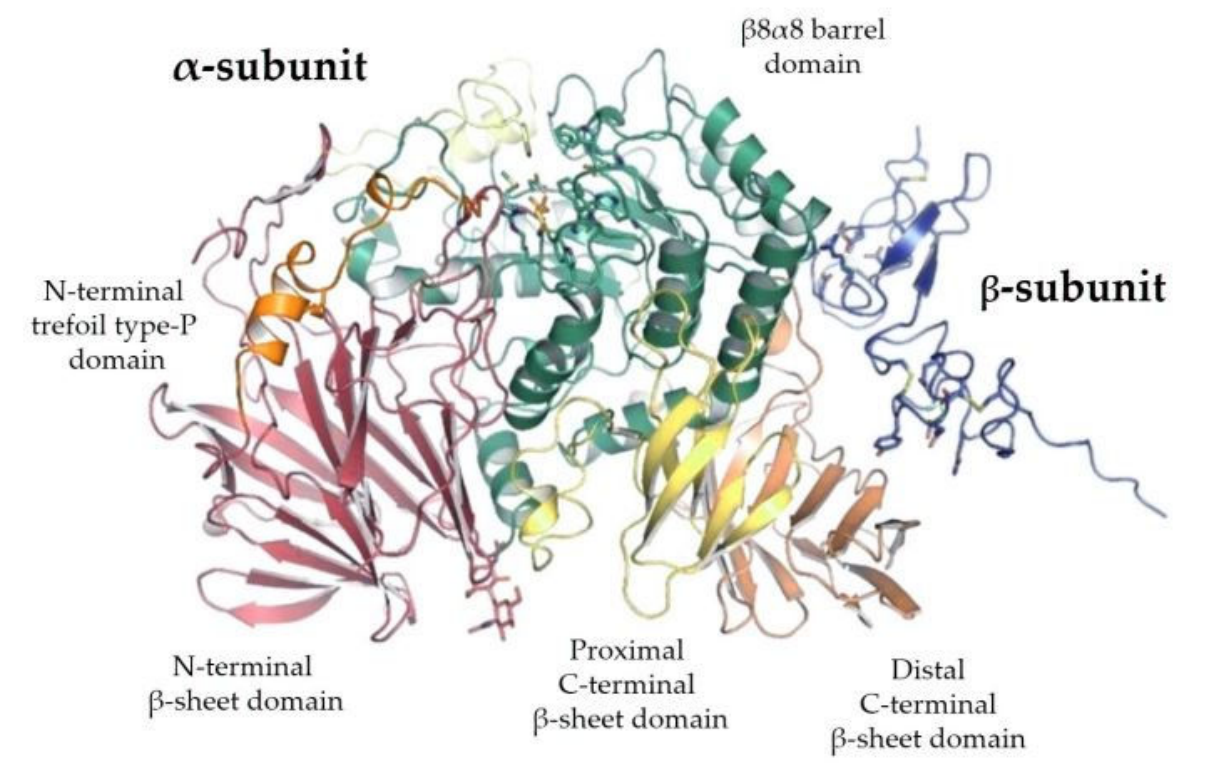
Figure 1. The ribbon structure of α - Glucosidase II heterodimeric complex. The α -subunit N -terminal trefoil type-P domain is shown in orange, and the N - terminal β -sheet domain is shown in pink. The α - subunit catalytic β8α8 barrel domain is shown in green. The Proximal and Distal α -subunit C - terminal domains are shown in yellow and light brown, respectively. Fin ally, the β -subunit is shown in blue.